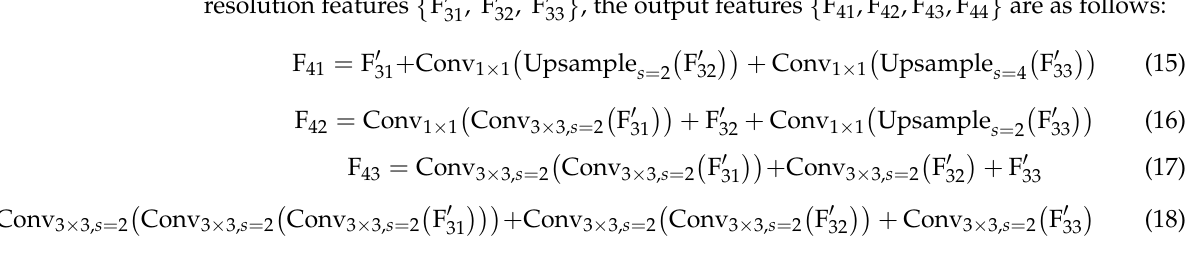
denote the operations of bilinear up-sample with stride-2 and stride-4, respectively.